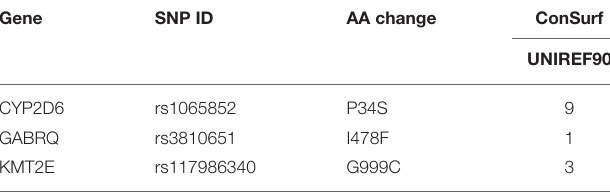
TABLE 4 | The evolutionary conservation analysis of nsSNPs by